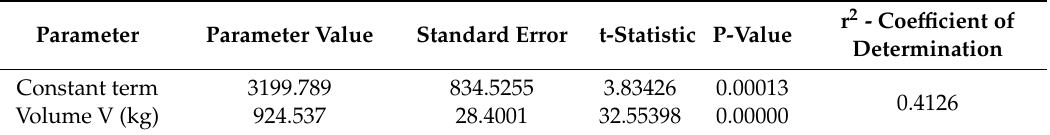
Table 5. Assessment of model parameters on load